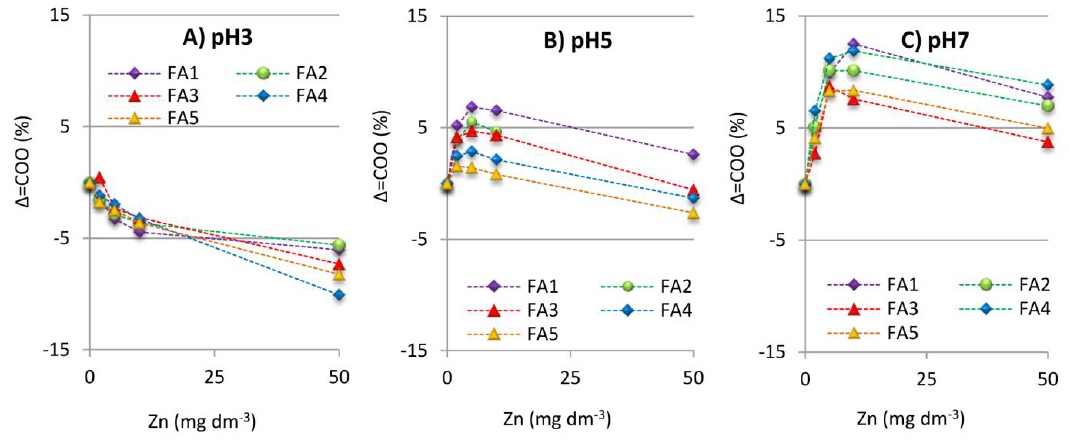
Figure 6. The distance between asymmetric and symmetric COO − bands ( ∆ COO − ) of the FA-Zn(II) compound in relation to the distance for ionic form of FAs for the systems at ( A ) pH 3; ( B ) pH 5; ( C ) pH 7.